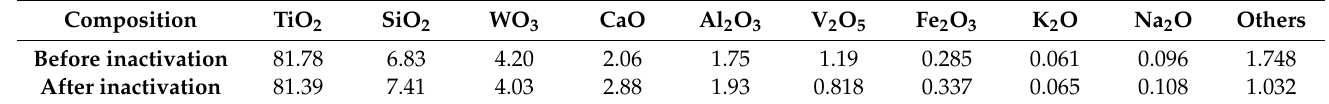
Table 2. Comparison of components before and after deactivation of SCR catalyst.